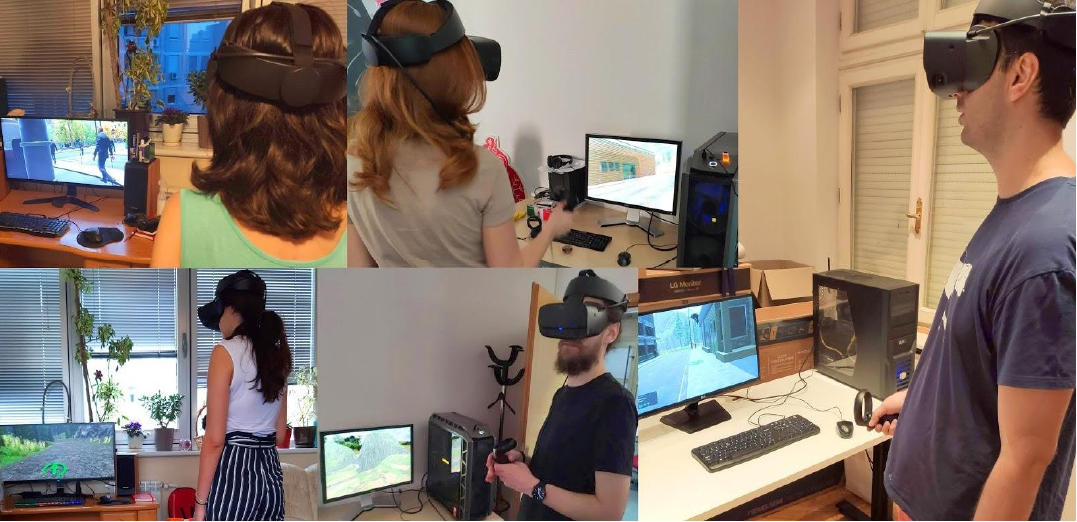
Figure 4. Testing the virtual simulation .